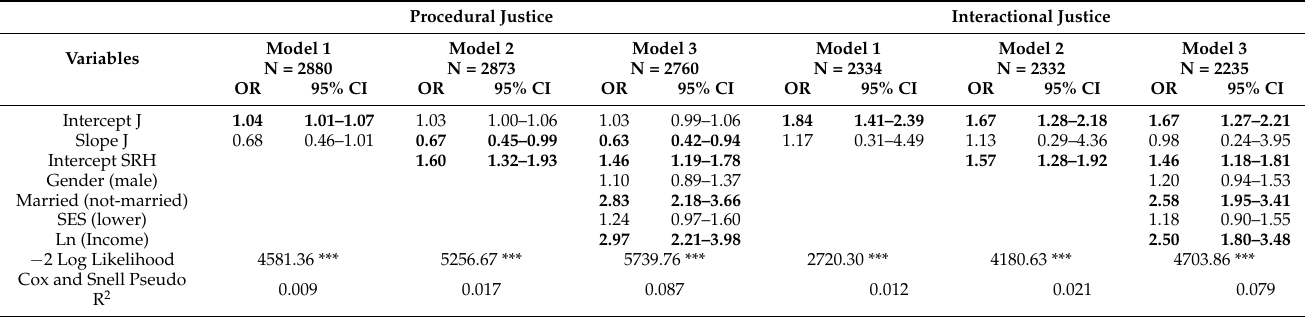
Table 4. ORs for late retirement as compared to early retirement (reference) for procedural justice and interactional justice.